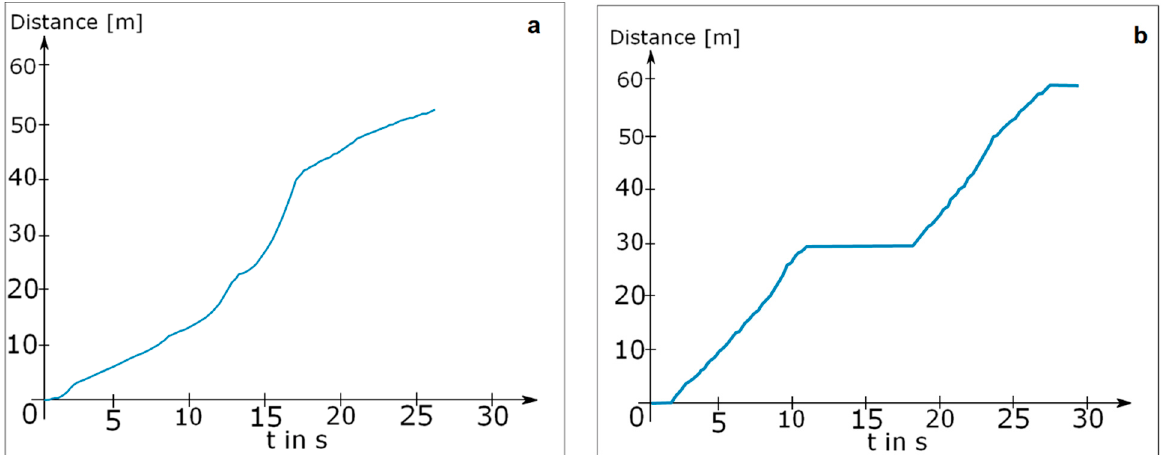
Figure 5. Acceleration of one foot with ( a ) calculated distance without rest detection; ( b ) calculated distance with rest detection.